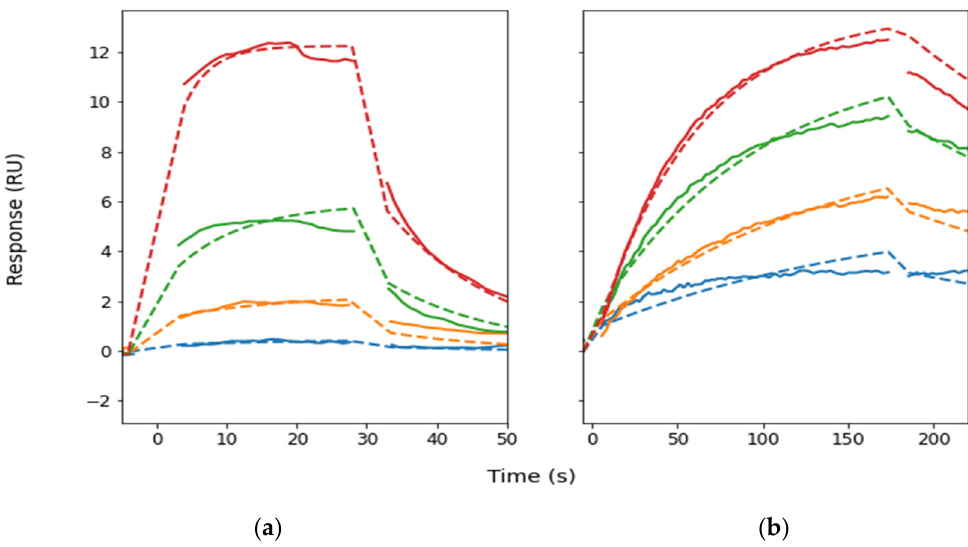
Figure 4. Biophysical characterization of Gap26 and Gap27 peptide binding. Gap peptides were injected over NTA surfaces with captured EL1 ( a ) and EL2 ( b ) on RadA-scaffolds. ( a ) RadA-EL1 with Gap27 (0.16–20 µM) and ( b ) RadA-EL2 with Gap26 (3–50 µM) showed clear differences in off-rates. The fit to a 1:1 binding model are shown as dashed lines. Colors indicate the concentrations of the injections in the order, from lowest concentration to highest: Table 2. Association and dissociation rates, dissociation constant K D : Gap peptides were injected over a surface with captured RadA-scaffolding protein, and the responses to dilution series were fitted to a 1:1 binding model. Fitted standard errors shown in parenthesis.